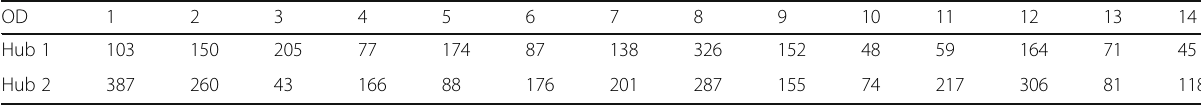
Table 2 Absorbed traffic flow